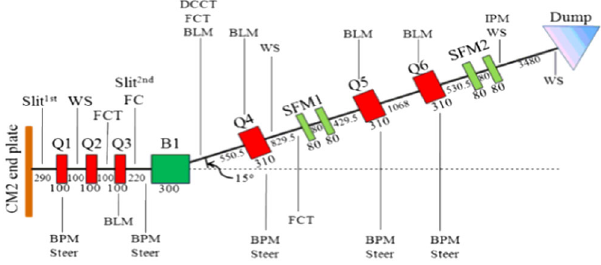
FIG. 26. The beam dump line layout of the ADS 10 MeV test stand at IHEP.